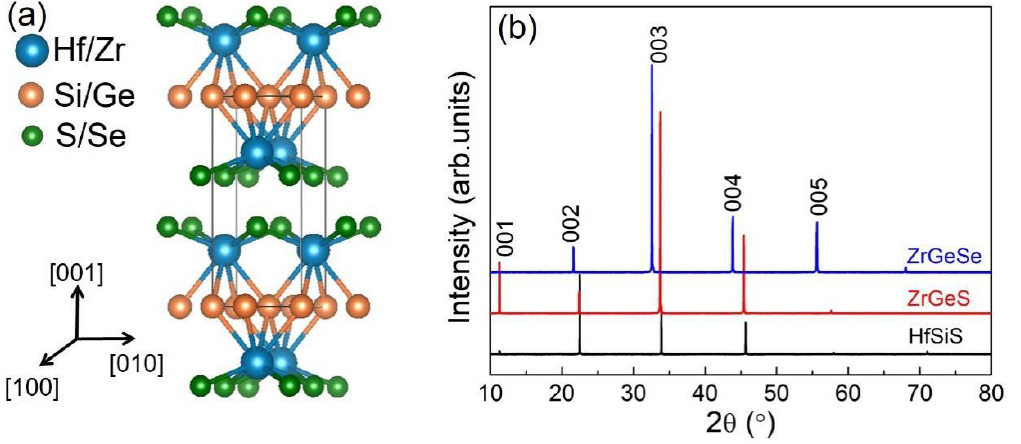
Figure 2. ( a ) The crystal structure of WHM-family Dirac semimetals. ( b ) X-ray diffraction (XRD) pattern of the as-grown single crystals of HfSiS, ZrGeS, and ZrGeSe.